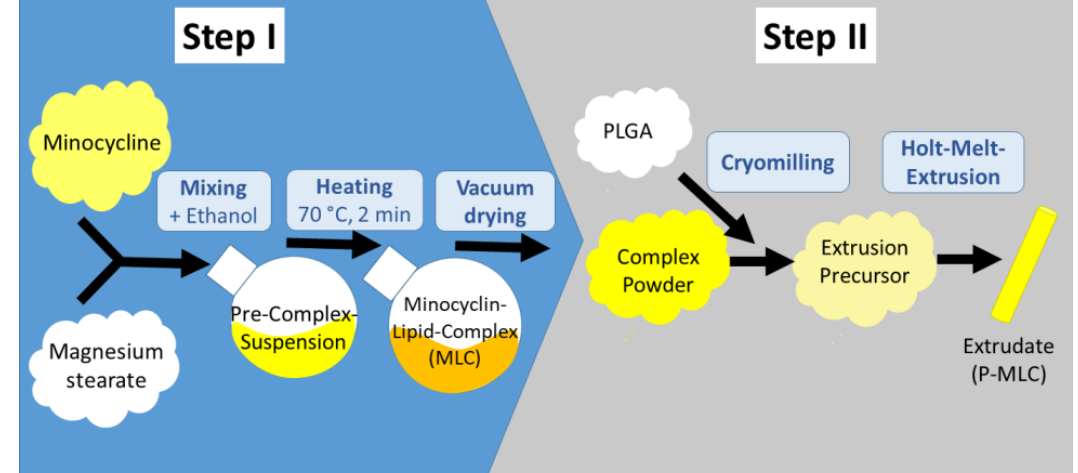
Figure 1. The investigated minocycline lipid complex (P-MLC) systems are manufactured in two sequential main steps. Step 1 includes the formation of the lipophilic minocycline lipid complex MLC by solvent and heat associated complex formation between minocycline and magnesium stearate. After evaporation of the intermediate solvent ethanol, the MLC complex is micronized, mixed with the biodegradable polymer poly-(lactide- co -glycolide) (PLGA), and extruded. As a result, a polymer-lipid complex extrudate P-MLC is obtained (diameter 600 µ m). Two di ff erent PLGA polymers were used P 502 -MLC and P 503